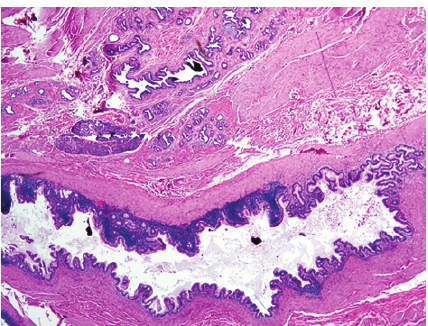
Figure 3: Histologic sections showing pools of mucin associated with an invasive adenocarcinoma and residual teratoma with por- tion of gut wall and pancreatic parenchyma. (H&E